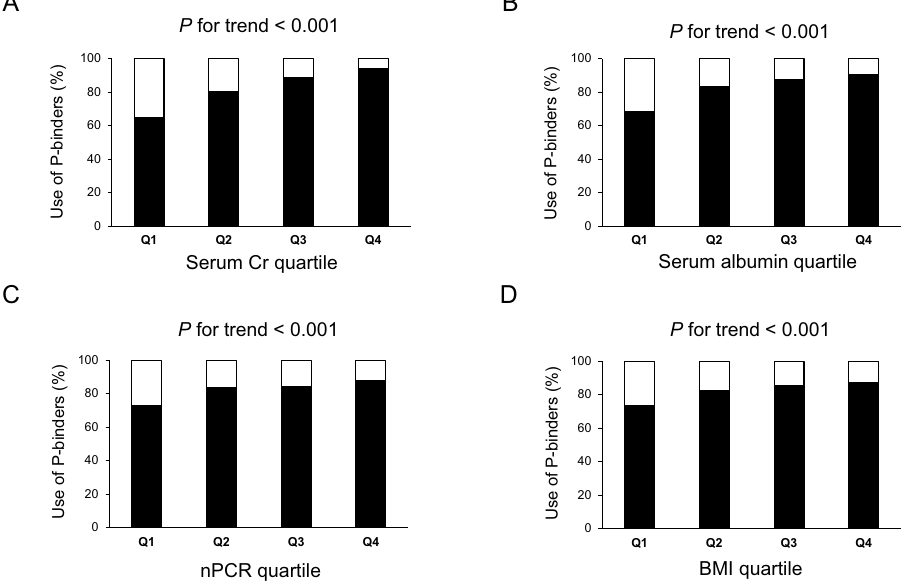
Figure 1. Percentage of phosphate-binders use in each quartile group stratified by nutritional indicators. ( A ) Serum Cr. ( B ) Serum albumin. ( C ) nPCR. ( D ) BMI. Patients were divided into quartiles based on serum Cr, serum albumin, nPCR, or BMI. Q1 is the lowest quartile and Q4 is the highest quartile. Cochran-Armitage trend analyses were used to determine the trend between use of phosphate-binders and each nutritional indicator quartile. A two-tailed P -value < 0.05 was considered to be statistically significant. Abbreviations: BMI, body mass index; Cr, creatinine; nPCR, normalized protein catabolic rate; Q,